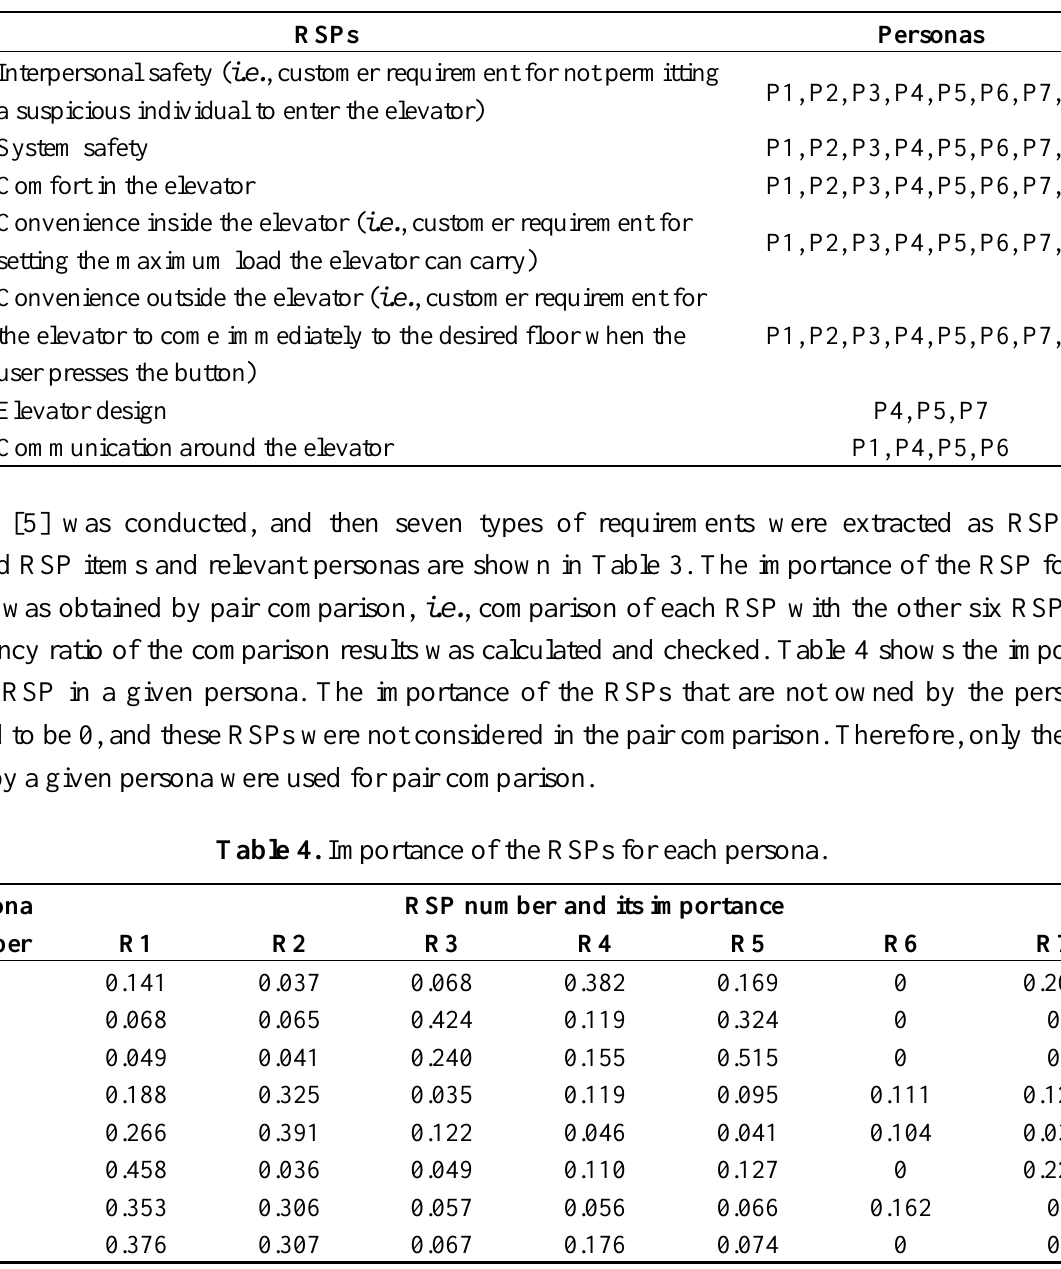
Table 3. The extracted receiver state parameters (RSP) items and relevant personas.